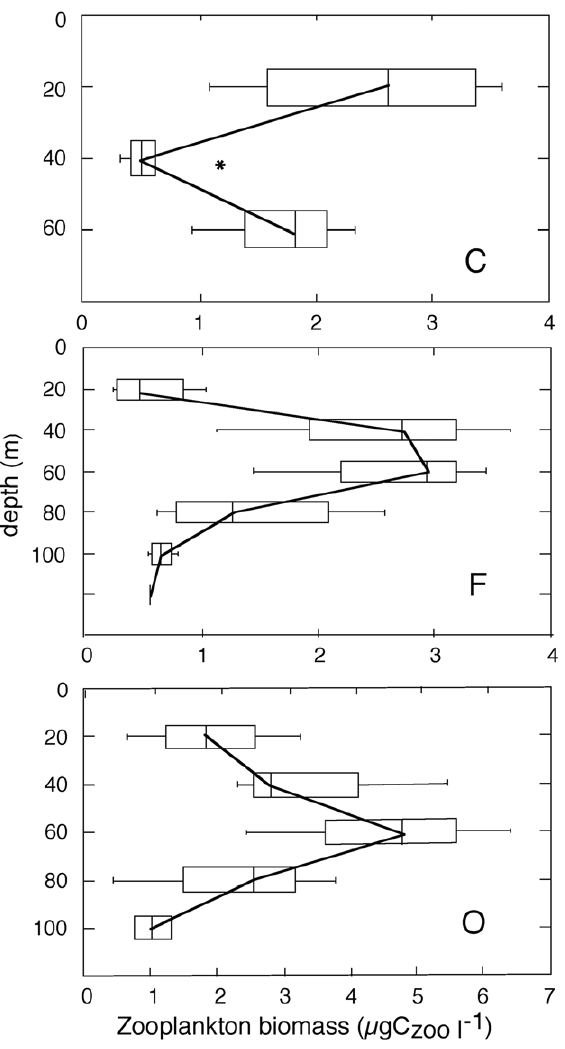
Fig. 3. – Box-plot of the average depth distribution of C L –1 ). C, F and O as in Figure 1. At Station C the maximum depth stratum sampled was 60 m, as the station depth was only 80 m. *: